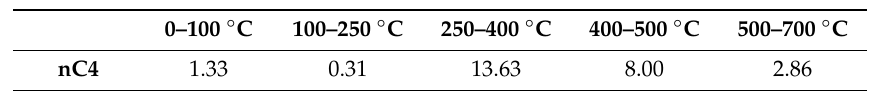
Table 4. Mass loss (%) of nC4.